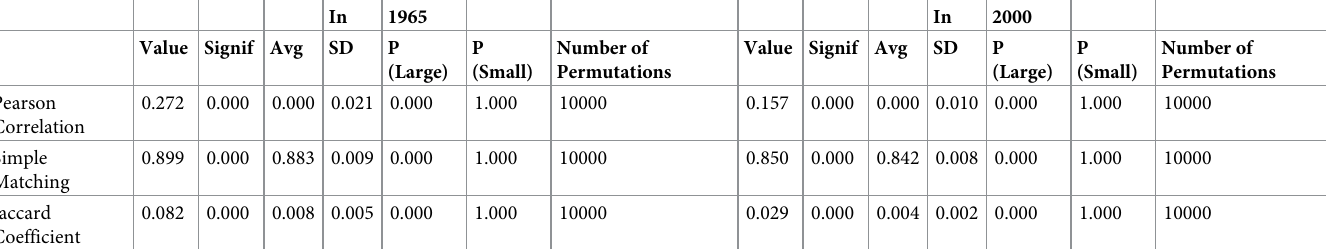
Table 3. Bivariate statistics of the political alliance network and the arms trade network (in 1965 and in 2000).